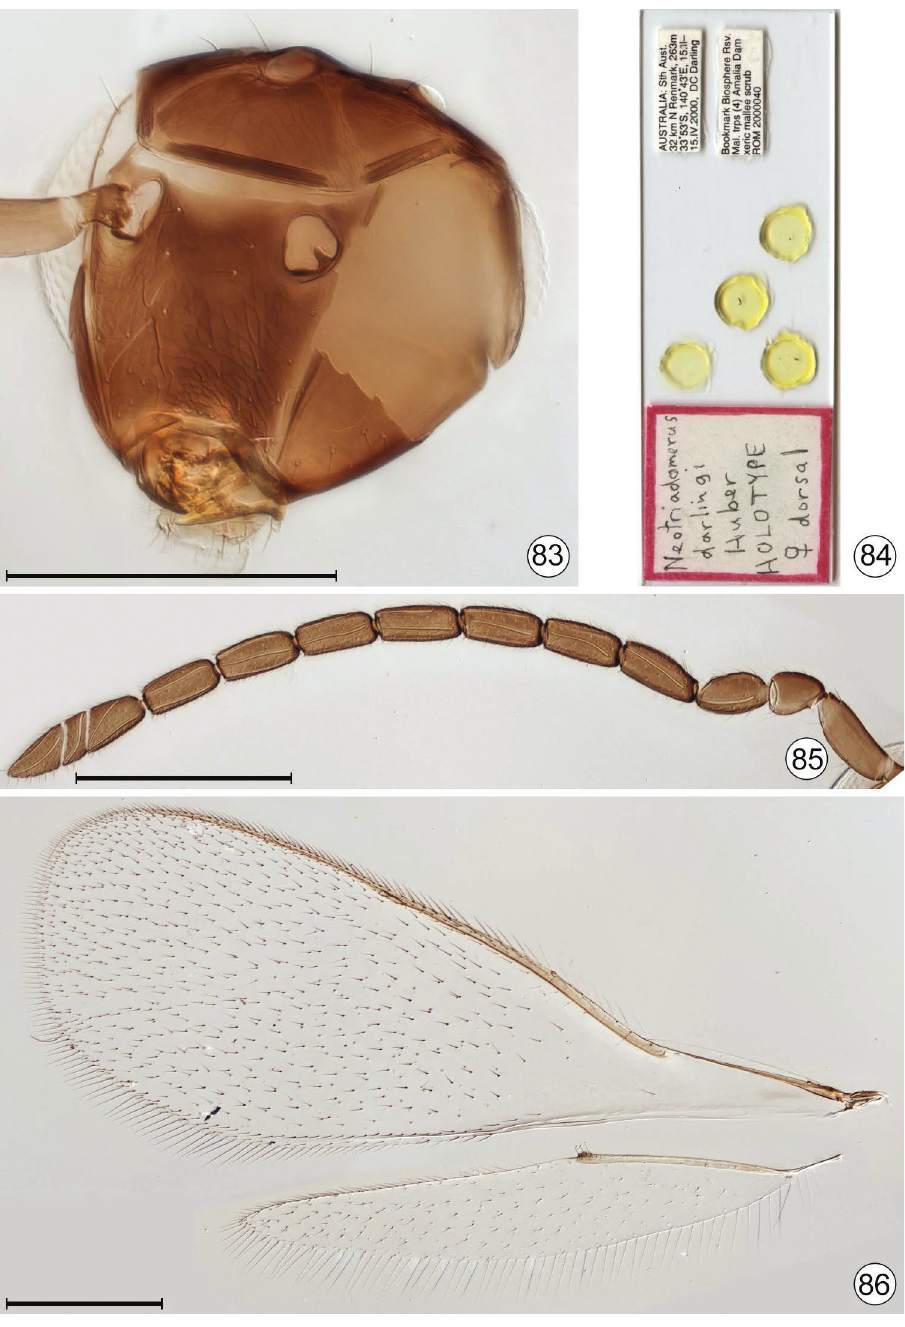
Figures 83–86. Neotriadomerus darlingi , holotype. 83 head, anterolateral 84 type slide 85 antenna 86 wings. Scale bar = 200